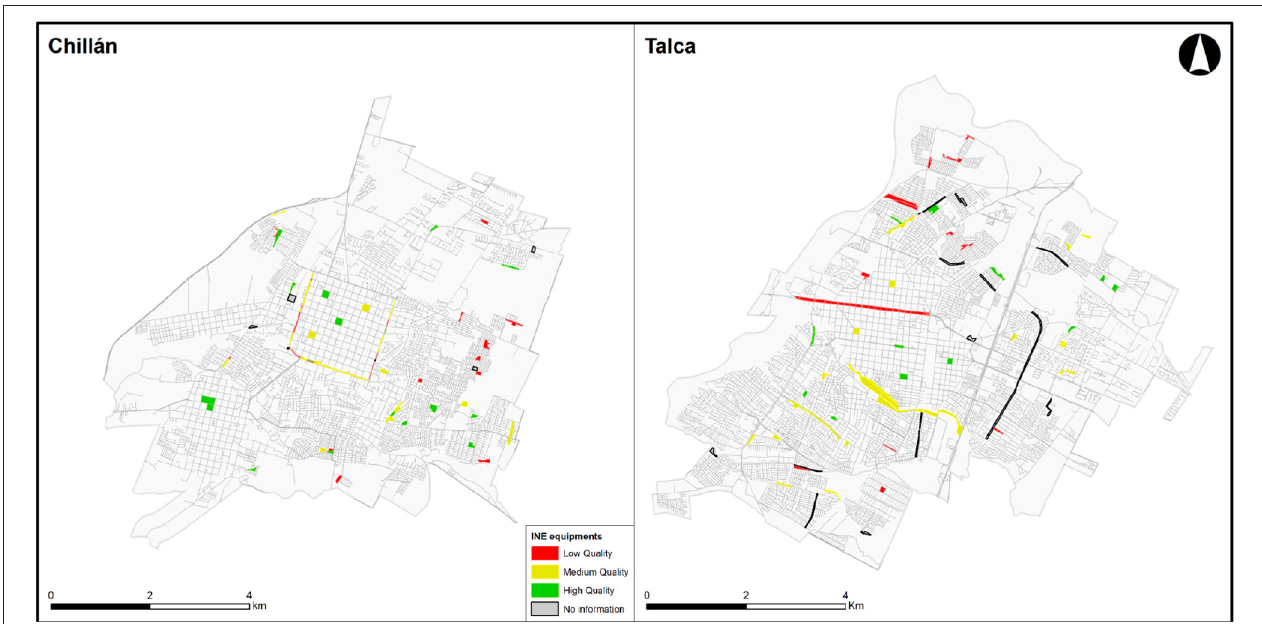
FIGURE 3 | Maps taken from the National Institute of Statistics’ online platform (INE, 2019), outlining size and location of green areas in the cities of Talca and Chillán. Colors indicate the square or park quality level out of three possible levels: red–low quality, yellow–medium quality, and green–high quality (gray indicates that no information on quality is available).